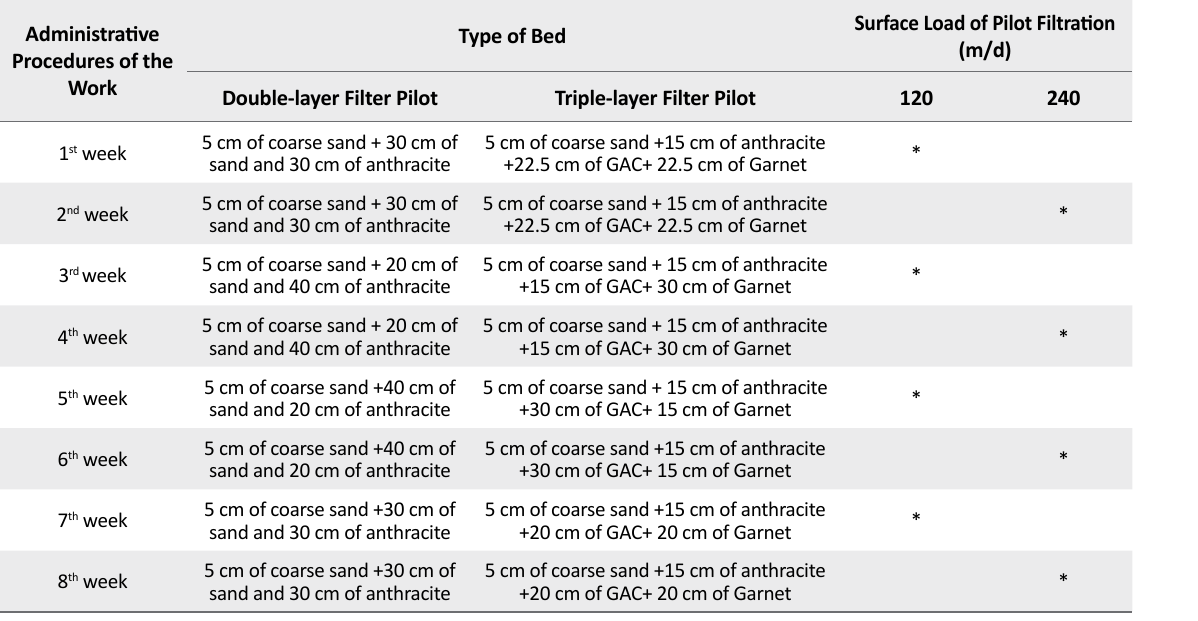
Table 3. Operational conditions of the used pilots